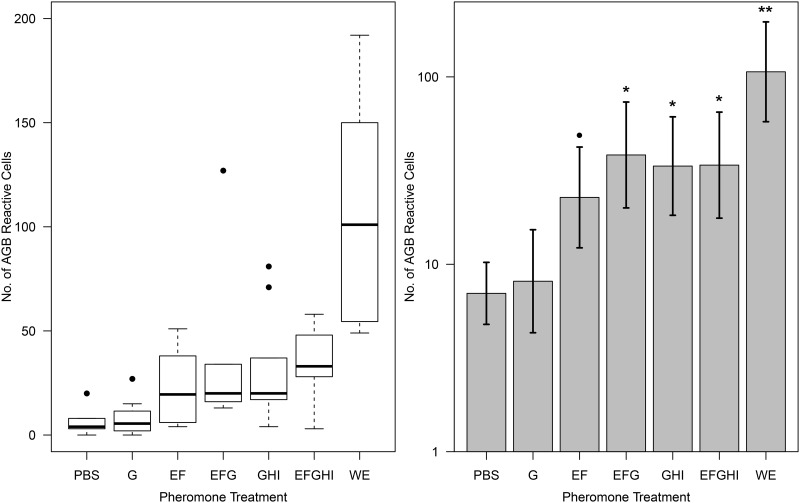
Summary of AGB neuron counts.(A) Box-and-whisker plots comparing the 7 pheromone treatments. The box defines the 25th and 75th percentiles, the median as the dark line, and whiskers as the minimum and maximum. Outliers are reported as values outside the median ± 1.5 * the interquartile range (box width). (B) Bar graph of the number of AGB reactive neurons per treatment (mean ± SE), with statistical significance relative to PBS denoted (●, p < 0.1; *, p < 0.05, **, p < 0.01)